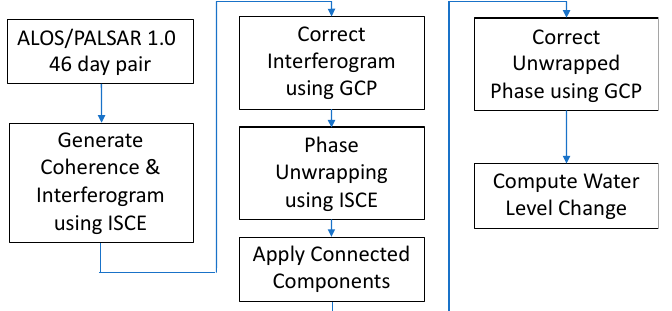
Figure 2. Flow diagram of InSAR processing, phase correction, and water level change retrieval (ISCE stands for InSAR Scientific Computing Environment).